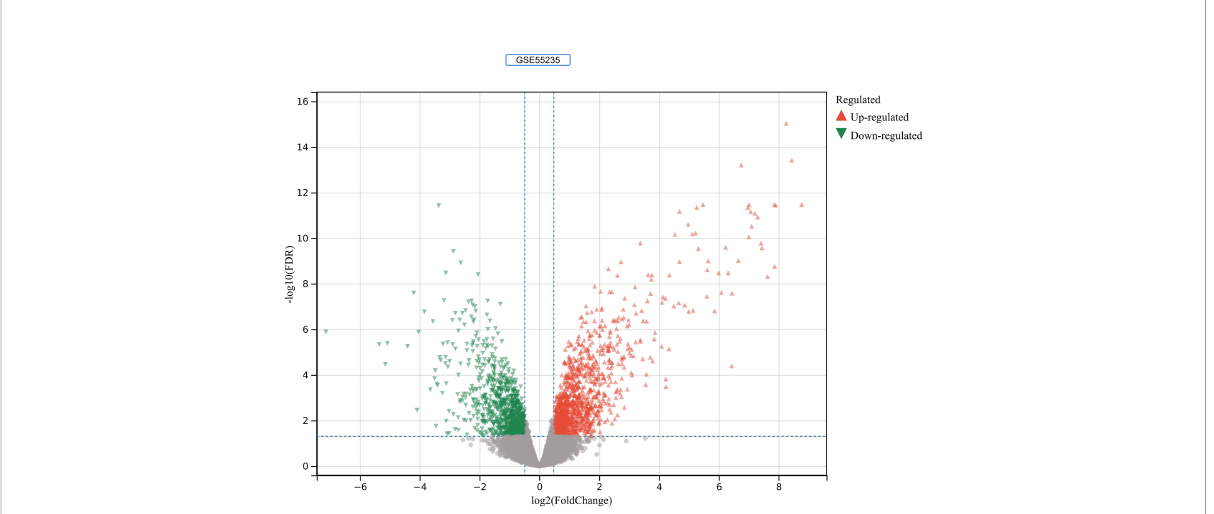
FIGURE 2 RA-DEGs identi fi cation. In the GSE55235 dataset, red triangles represent upregulated genes ( P < 0.05), green triangles represent downregulated genes ( P < 0.05), and gray dots represent genes not signi fi cantly differentially expressed across the RA and HC groups ( P >